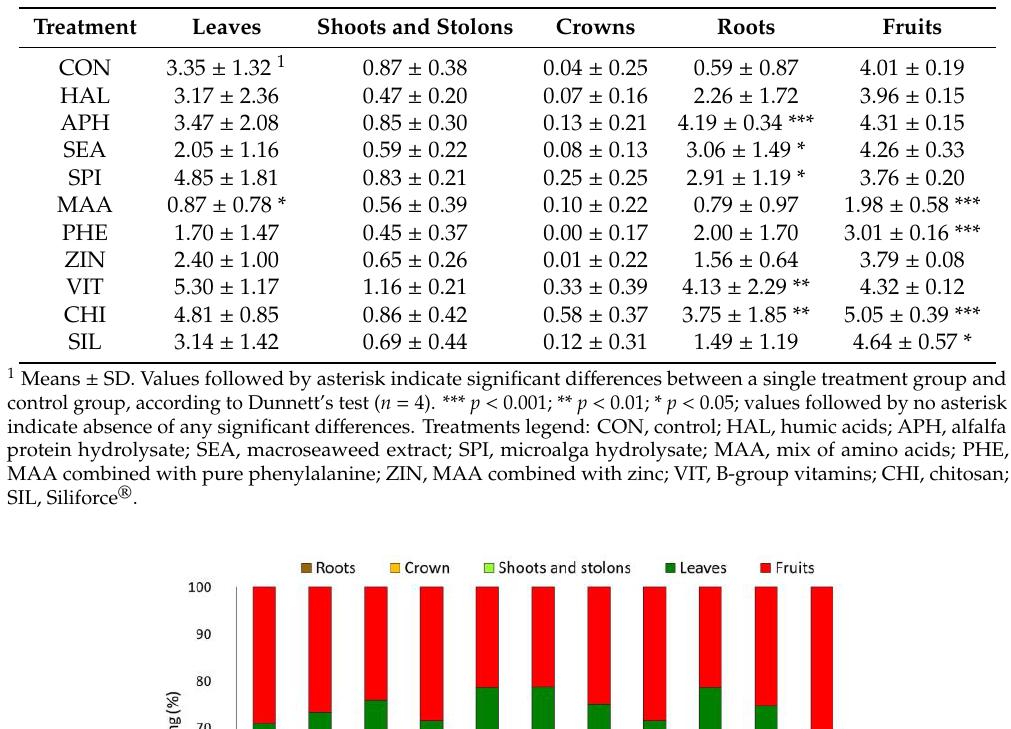
Table 4. Accumulated biomass in different plant organs (g DW plant -1 ) as affected by biostimulant applications.